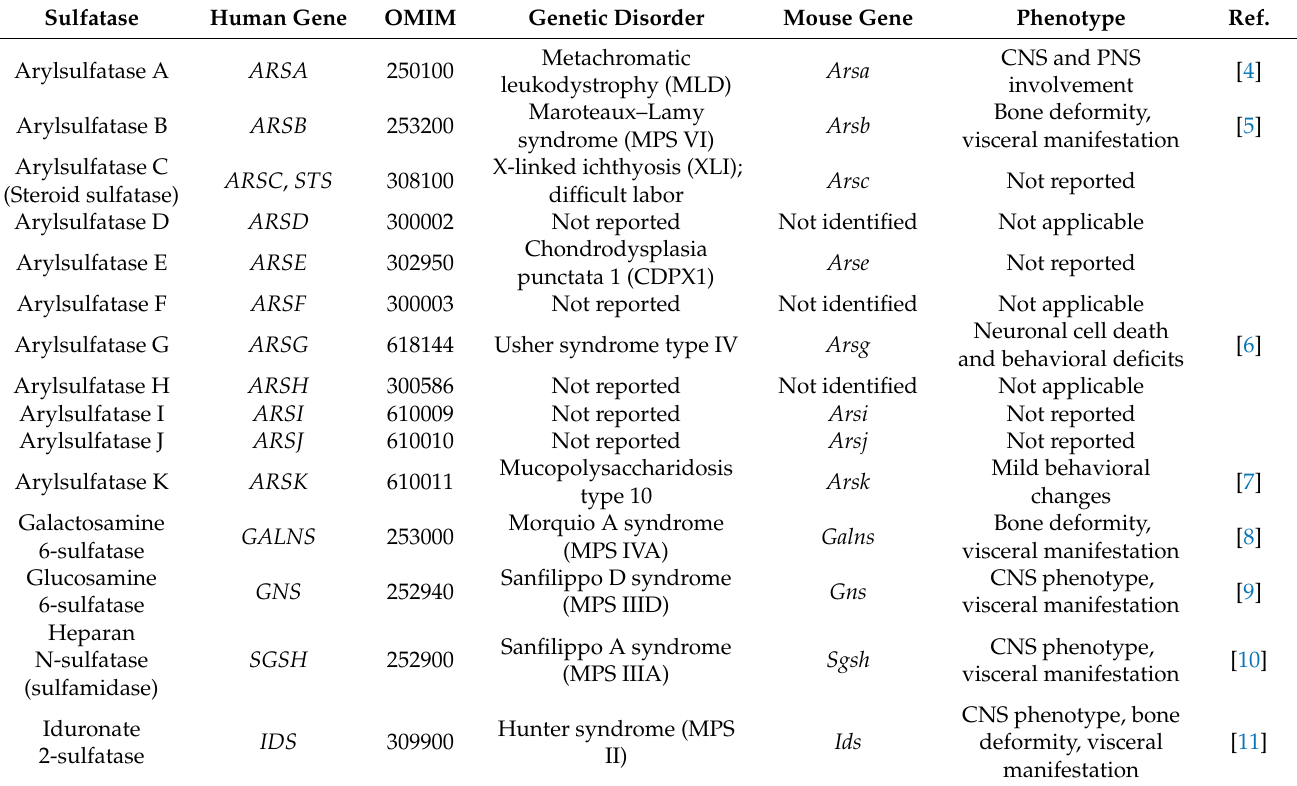
Table 1. Sulfatases in humans and mice.